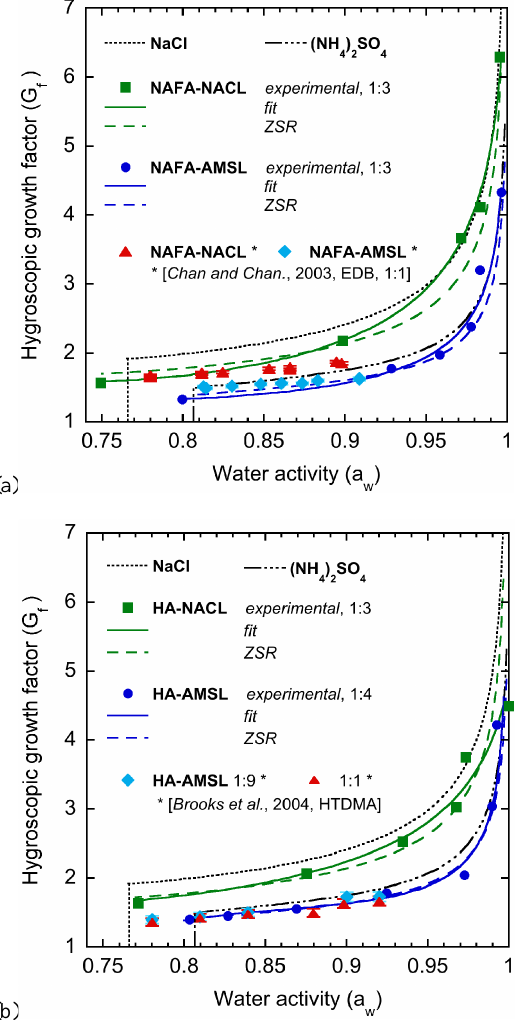
Fig. 7. Hygroscopic growth factor as a function of water activity at 25 ◦ C for the mixture of inorganic salts with (a) NAFA, and (b) HA. Solid symbols show growth factors calculated from bulk so- lution measurements using Eq. (3). Solid lines represent the fit to the data based on the water activity parameterizations presented in Table 1, while dashed lines denote the hygroscopic growth factor as predicted by the ZSR method. The curves for pure sodium chloride (dotted line) and ammonium sulfate (dotted-dashed line), including their deliquescence points (vertical lines), are given for reference. Published data for similar mixtures was included: (a) EDB measure- ments by Chan and Chan (2003) at 22.5–23.8 ◦ C, and (b) HTDMA data by Brooks et al. (2004) at 30 ◦ C.